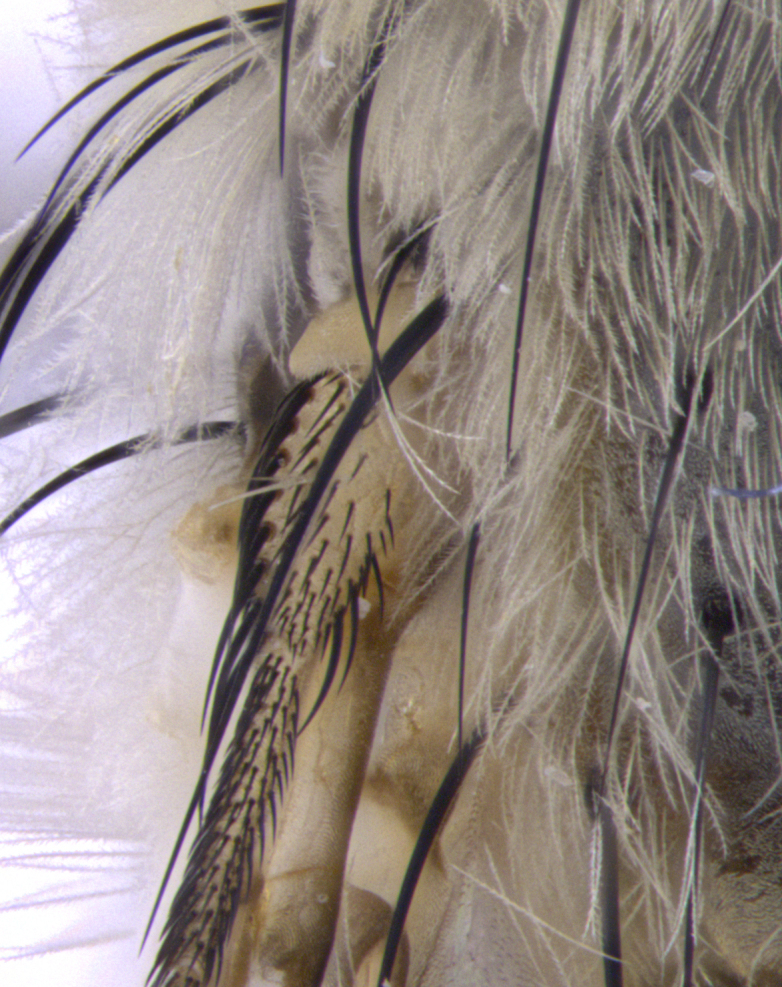
Telothyria
fimbriata
sp. n. displaying the ivory white color basicosta.